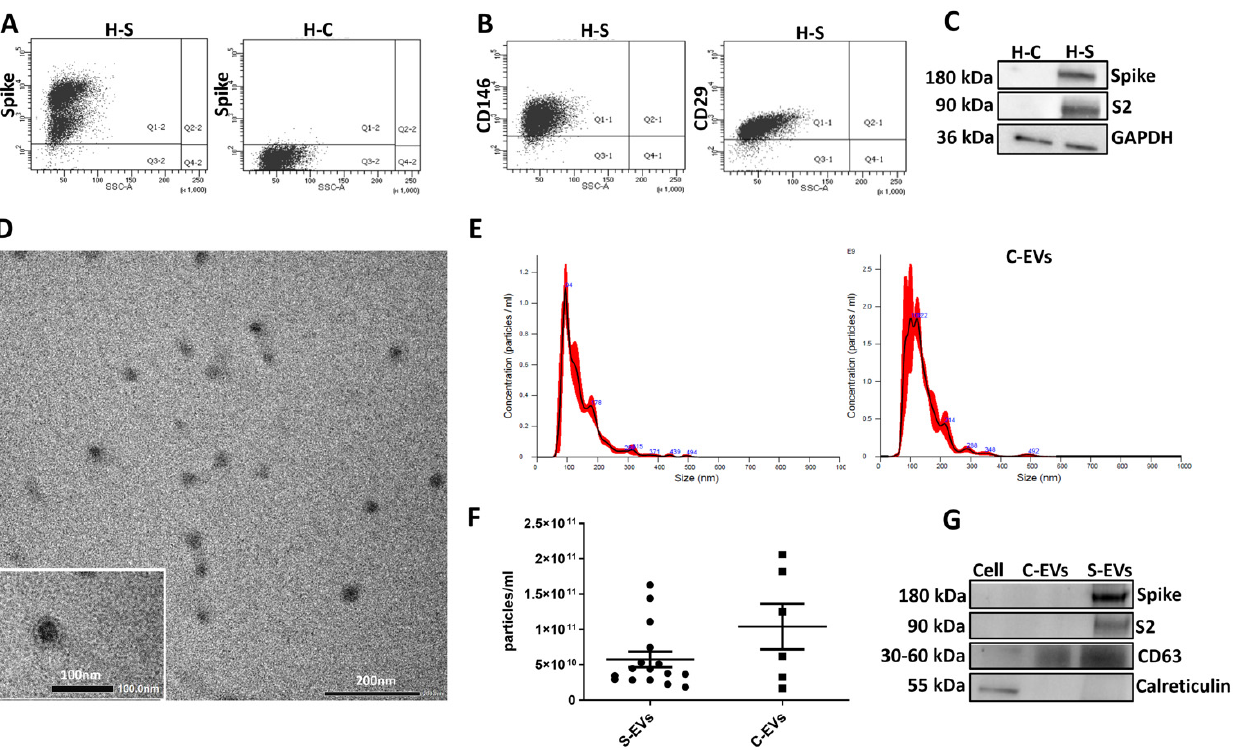
Figure 1. Characterization of H-S and EVs with validation of spike presence. ( A ) Representative flow cytometry analysis of spike protein in H-S and H-C. ( B ) Representative flow cytometry analysis of H-S showing positive expression of CD146 and CD29. ( C ) Representative western blot images of both full-length spike protein and S2 subunit (spike and S2) in H-S and H-C. GAPDH was used as an endogenous loading reference. ( D ) Representative micrograph of transmission electron microscopy of S-EVs (Scale bar: 200 nm; insert: 100 nm). ( E) Representative nanoparticle tracking analysis of EVs from H-S cells (S-EVs) and from H-C cells (C-EVs) showing EV size distribution. ( F ) The graph shows EV sample quantifications. ( G ) Western blot images of spike subunits in S-EVs and C-EVs. CD63 was used as an exosomal marker and calreticulin as a negative EV marker.